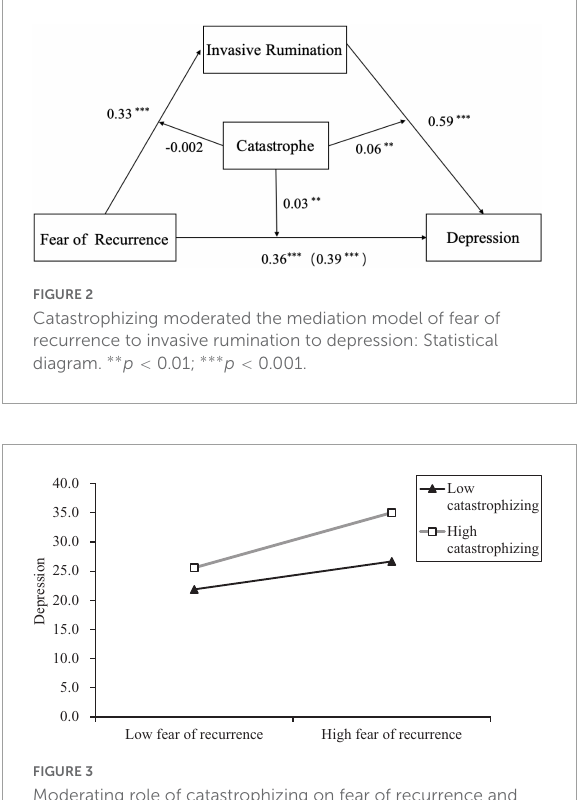
FIGURE3 Moderating role of catastrophizing on fear of recurrence and